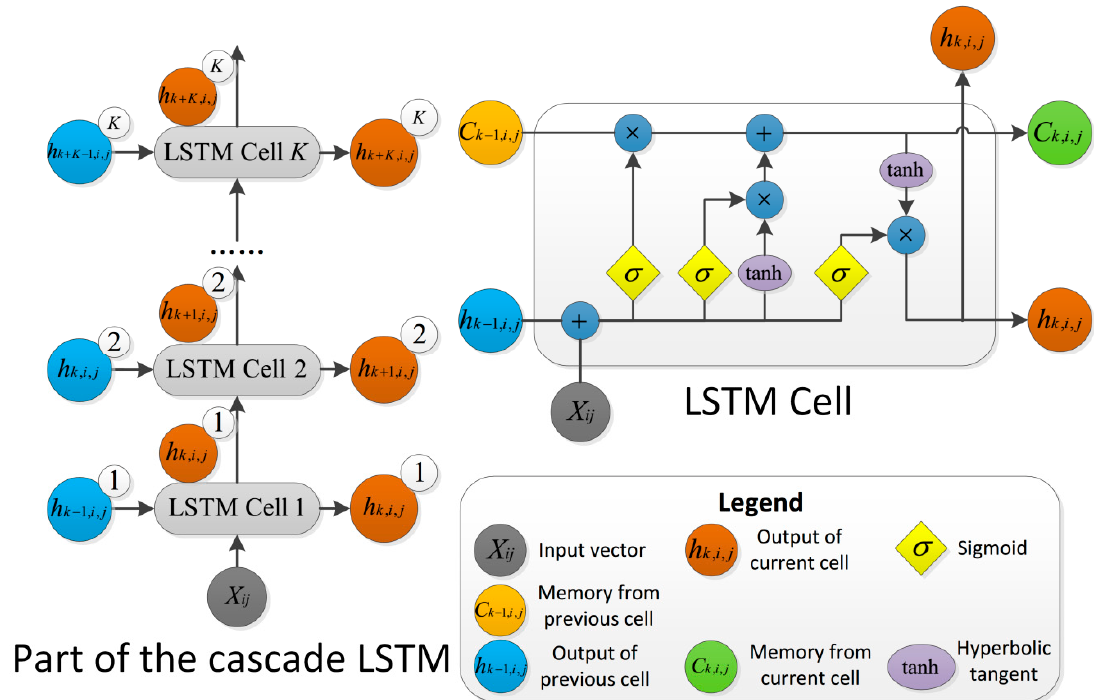
Figure 3. LSTM structure diagram.